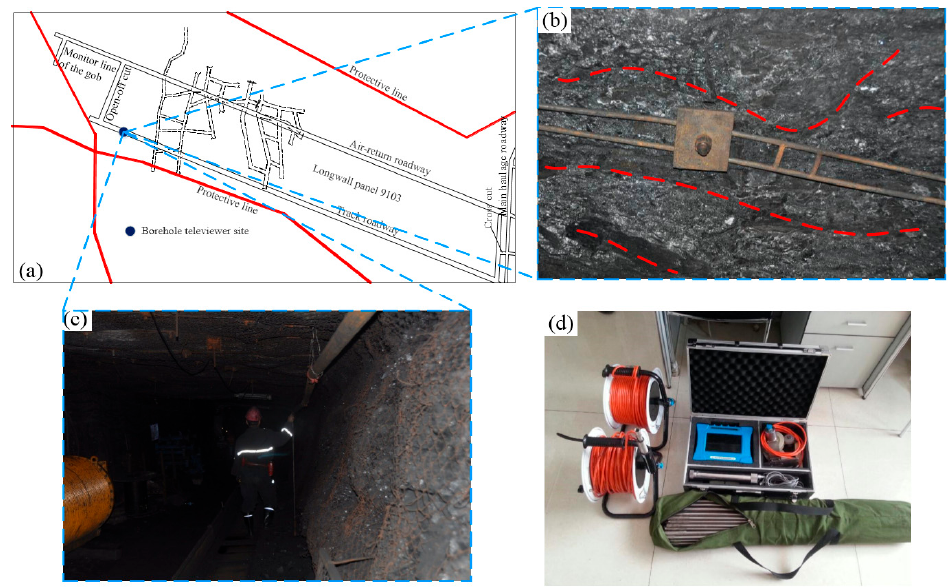
Figure 8. ( a ) Plan view of the study site at Huahong coal mine, China; photographs of ( b ) roof ( c ) rib; ( d ) test equipment of borehole image.